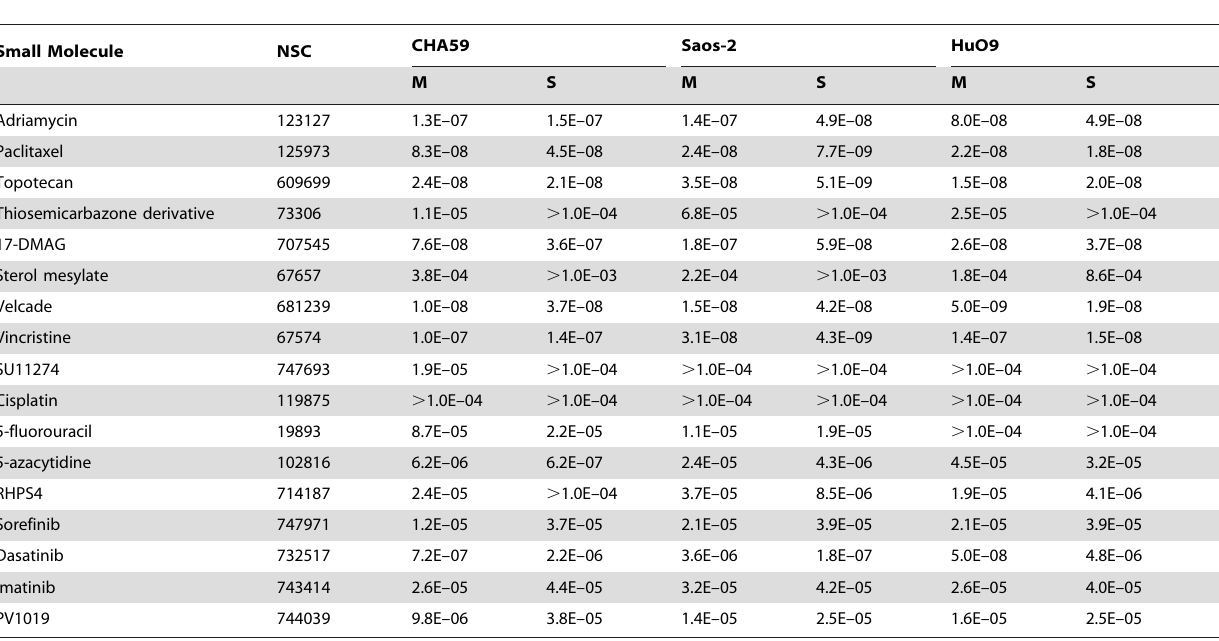
Table 1. Differential drug resistance of CHA59, Saos-2, and HuO9 monolayer vs. sphere.